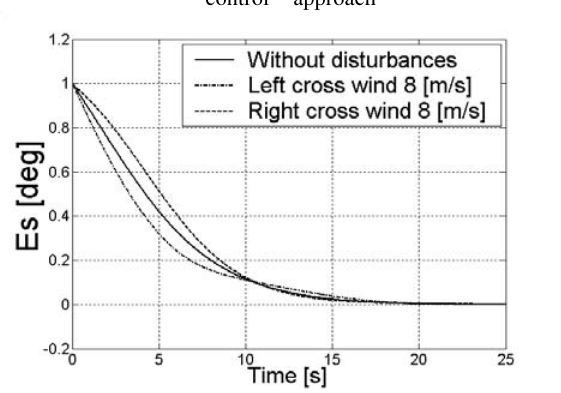
Fig 7a. Simulation results with the use of model-following control – approach